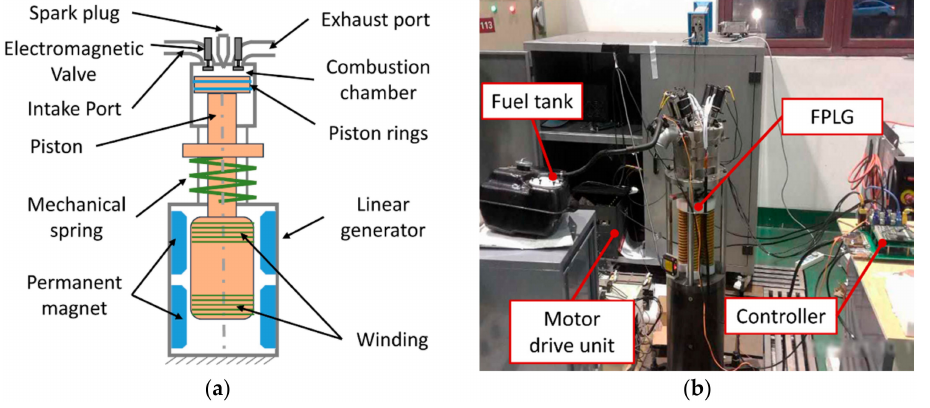
Figure 1. Basic configurations of FPLG, ( a ) The structure diagram; ( b ) The prototype of FPLG.